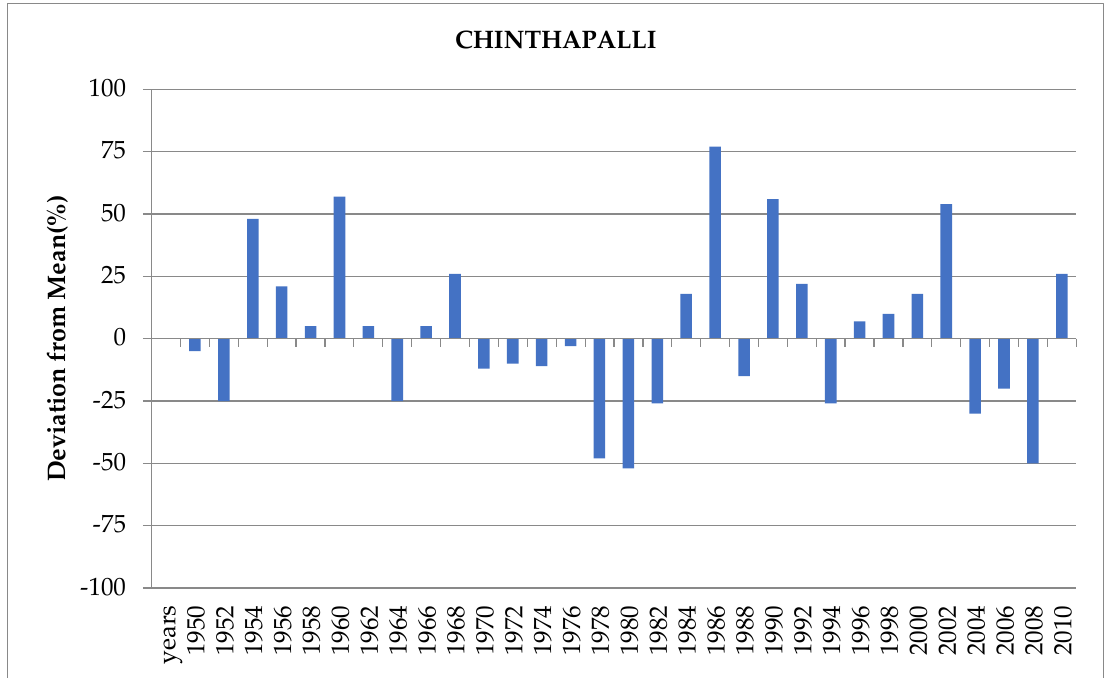
Figure 13. Annual rainfall deviations.